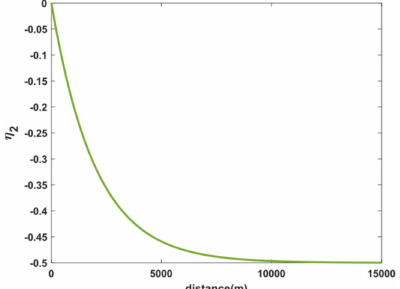
Figure 6. Change in η 2 with the distance between two UCAVs.